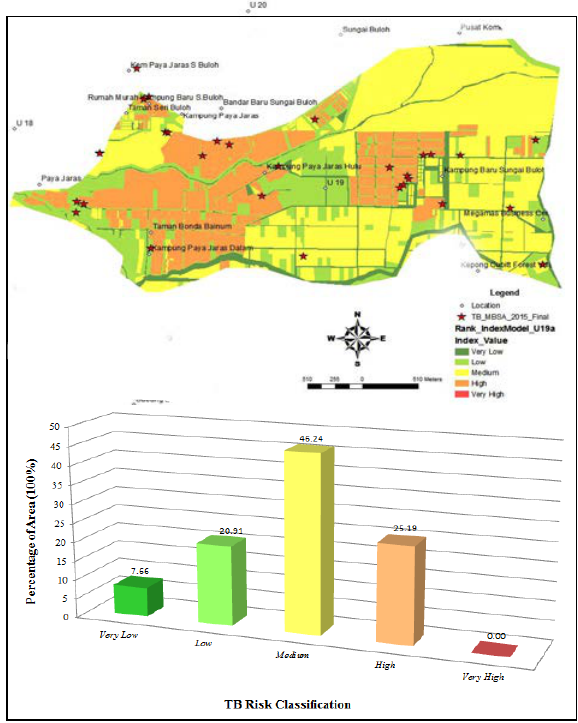
Figure 5. Potential risk areas of tuberculosis at Section